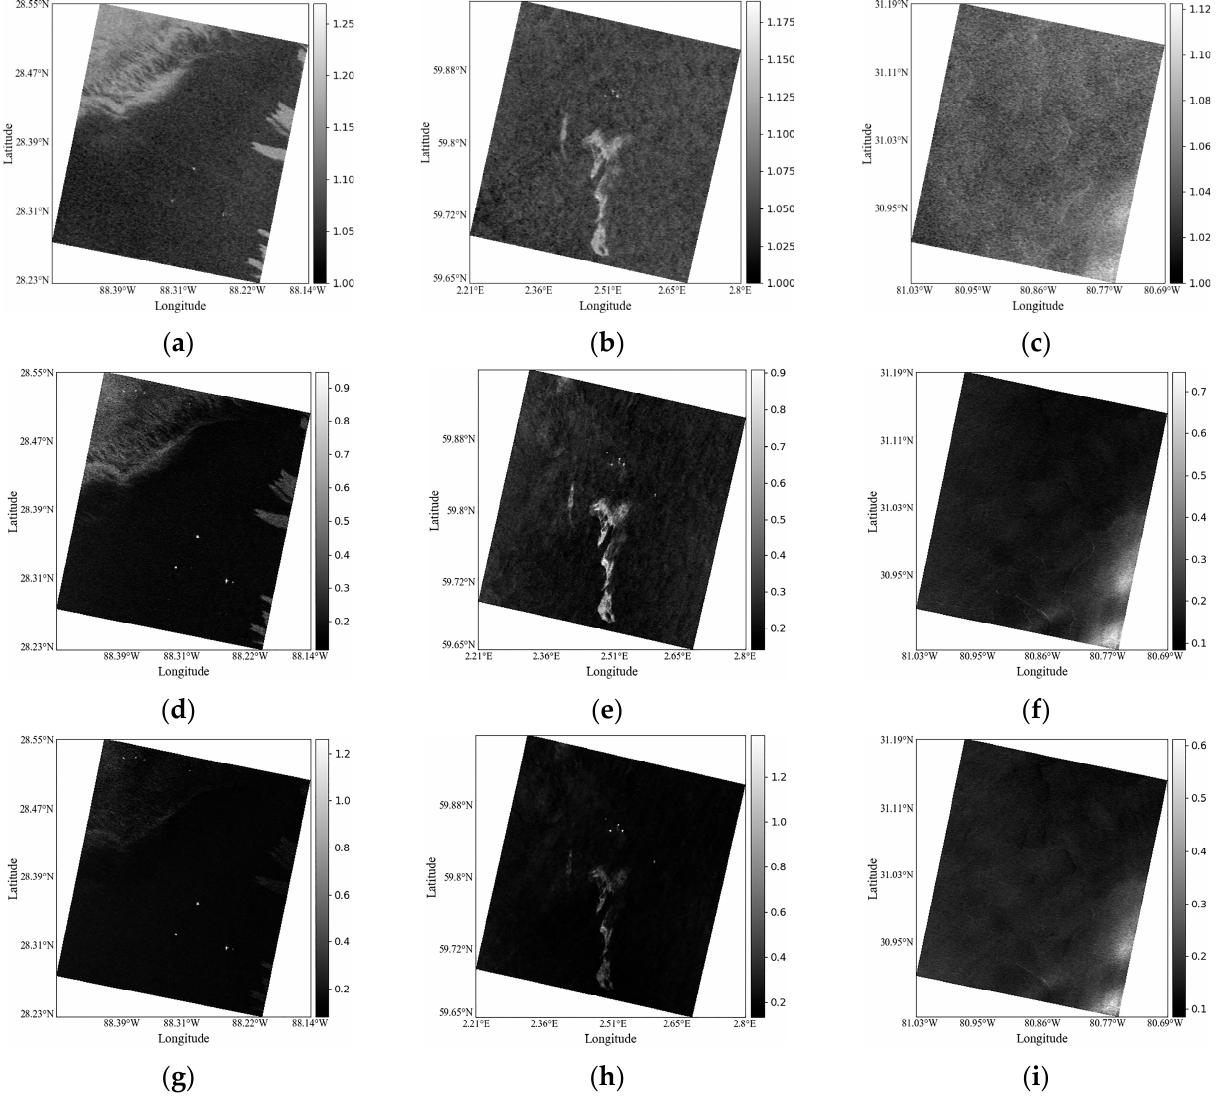
Figure 10. Feature images for Case 2, Case 3, and Case 5. ( a – c ) are 𝑃𝑅 (cid:3045) images. ( d – f ) are 𝐻 images. ( g–i ) are 𝛼 images. ( g–i ) are α